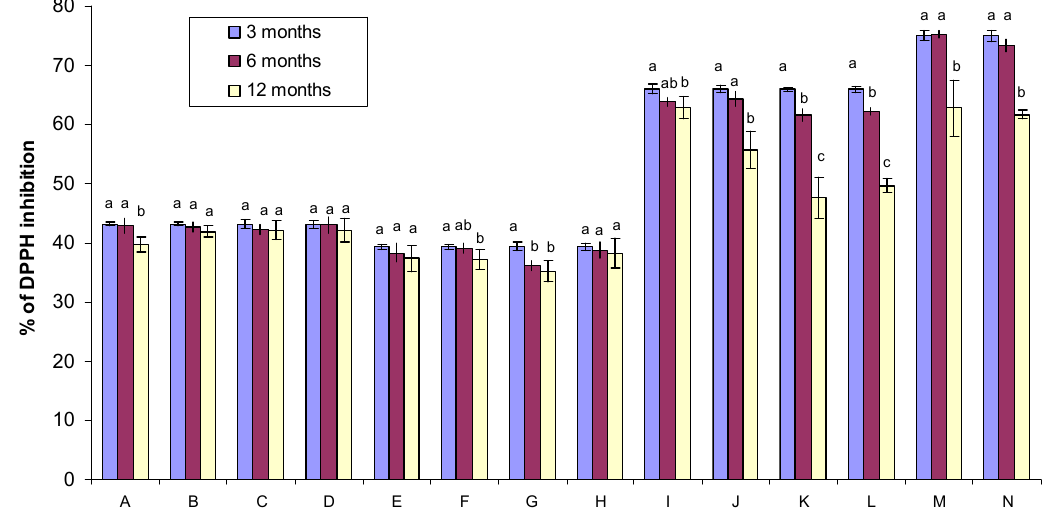
Figure 3. Comparison of the DPPH radical-scavenging activities of Tualang honey samples exposed to different storage conditions (data obtained after 6 and 12 months were compared with the base line data obtained after three months). Different letters (a, b and c) indicate significant differences ( p < 0.05). The letters “A” to “N” indicate the sample code (Table